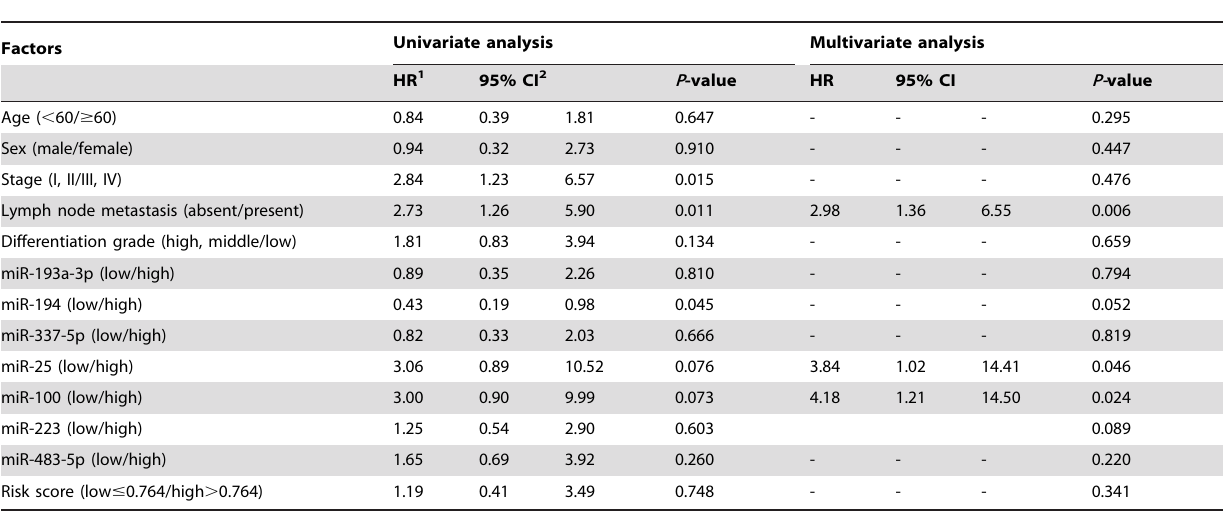
Table 3. Univariate and multivariate analyses of parameters associated with overall survival of all oesophageal squamous cell carcinoma (ESCC)